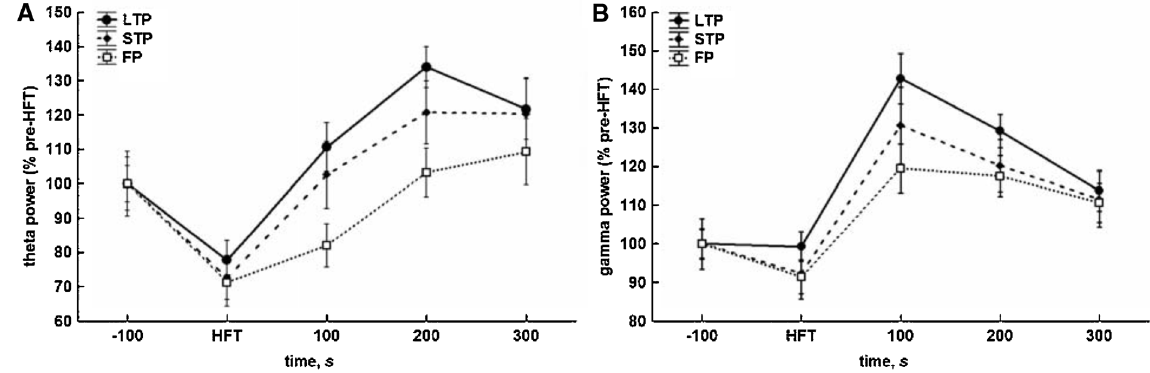
Figure 3. Different consequences of tetanisation are characterised by distinct profiles of changes in theta (5–10Hz) and gamma (30–100Hz) spectral power in the DG invivo. ( A ) HFT-induced increase in theta spectral power is more prominent in LTP and STP, but not the failed potentiation group. ( B ) HFT induces an increase in gamma spectral power with the peak within first 100seconds after stimulation. The results were pooled for 10 4-second-long epochs for each of five 100-seconds-long periods and are expressed as Mean (cid:3) SEM.